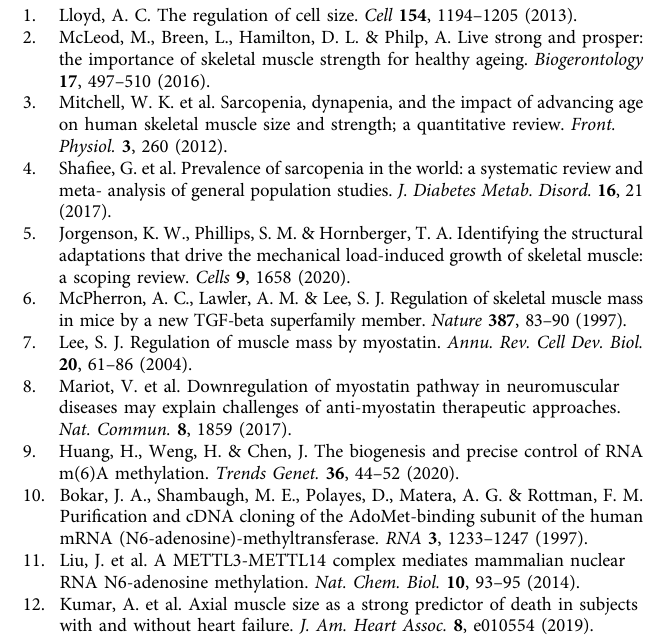
Fig. 6 Hypertrophy defects in METTL3-mKO mice are rescued with myostatin inhibition. a Relative m 6 A enrichment, determined by qPCR analysis, following m 6 A immunoprecipitation in WT plantaris muscles following 7 days of sham (base) or overload (overl) surgeries. b Western blot of p-SMAD3 (p = phospho), total SMAD3 and GAPDH expression in muscles of WT and M3-mKO mice at baseline or 7 days following muscle overload. c qPCR analysis of Murf1 (muscle-speci fi c ring fi nger protein 1) and d Mafbx (muscle-atrophy F-box protein) expression in WT and M3-mKO muscles. e